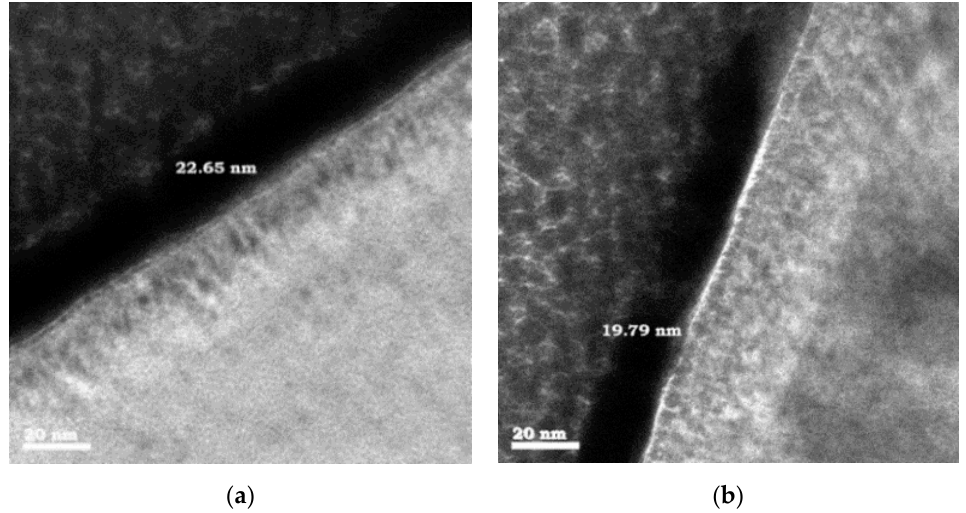
Figure 2. Cross-sectional TEM images of ( a ) HfO 2 -HEMT and ( b ) TiO 2 -HEMT. The unpassivated and passivated HEMTs are subjected to high-temperature testing. Figure 3 presents the drain currents ( I DS ) at different temperatures versus drain-to-source voltage ( V DS ). The DC measurements are taken as functions of temperatures over the range 300 to 420 K. Figure 4 shows the extrinsic transconductance ( g m ) and drain current versus gate-to-source voltage of the studied HEMTs at various temperatures. The gate voltage swing (GVS) is defined by the voltage range within which the g m value deviates from its maximum value by 20%. The GVS value is increased from 1.7 V to 3.2 V at 300 K after TiO 2 passivation. I DS versus V DS at pinch-off conditions and the threshold drain current charac- teristics at 300 K for the three HEMTs herein were studied [11]. Figure 5a plots drain cur- rent at V GS = 0 V ( I DSS ) versus temperature of the studied HEMTs. Experimental results reveal that I DSS values of the studied HEMTs are increased when the HEMTs are passiv- ated. The increased drain current density is attributable to the increased sheet electron concentration after passivation [8,11]. The studied three HEMTs depicts good pinch-off characteristics at various temperatures. Increasing the temperature decreases I DSS . The falloff in drain current density at elevated temperatures result from the degradation of the electron mobility. Furthermore, the threshold voltage ( V th ) is extracted by linear extrapo- lation of the root of drain current against V g curves. The values of V th of the TiO 2 -HEMT are − 5.5, − 5.33, − 5.2, − 4.96, and − 4.89 V at 300, 330, 360, 390, and 420 K, respectively. The magnitude of the V th value is reduced at high temperature because of the decreased drain current density.